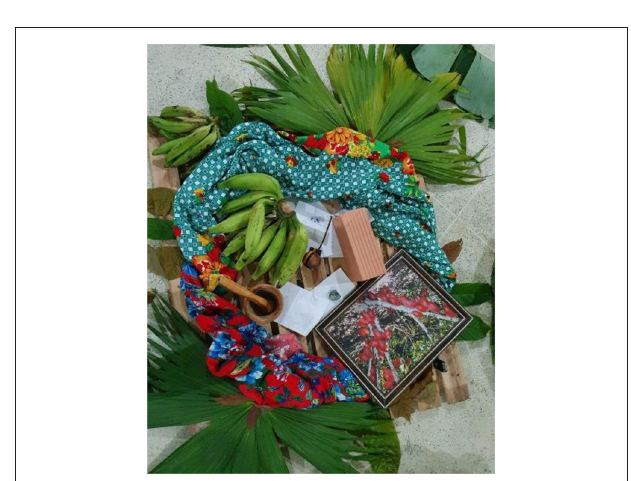
FIGURE 5 | A roda de conversa during a Brazil CAG meeting. Sri Lanka